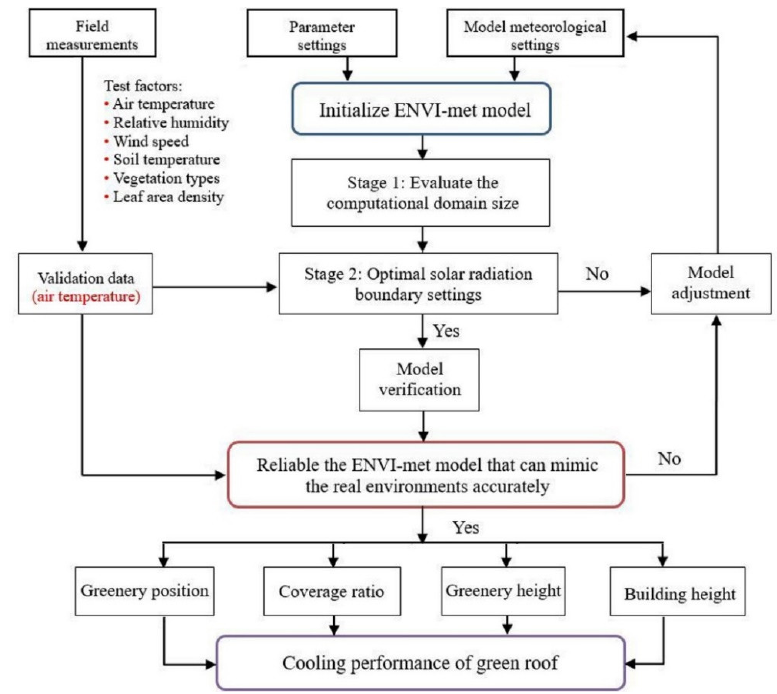
Figure 4. A framework for comparative analyzing cooling performance of green roofs under different scenarios.